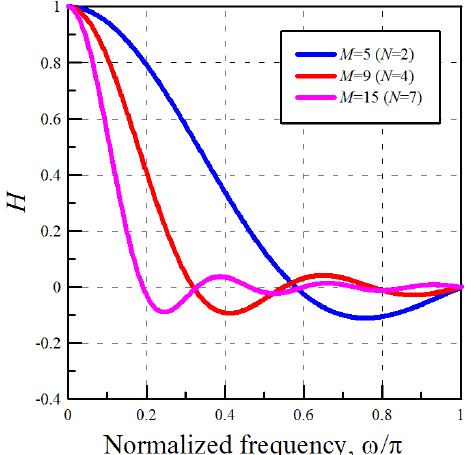
Figure 3. The signal described by Eq. (5) (red line), together with its first derivative (blue dotted line). The high-frequency components of the signal are amplified in the derivative. Figure 4. The frequency responses of the low-pass filter embedded with an SG2 derivative filter and estimated with Eq. (10) ( H L , i.e., the dSG2 low-pass filter) at different M